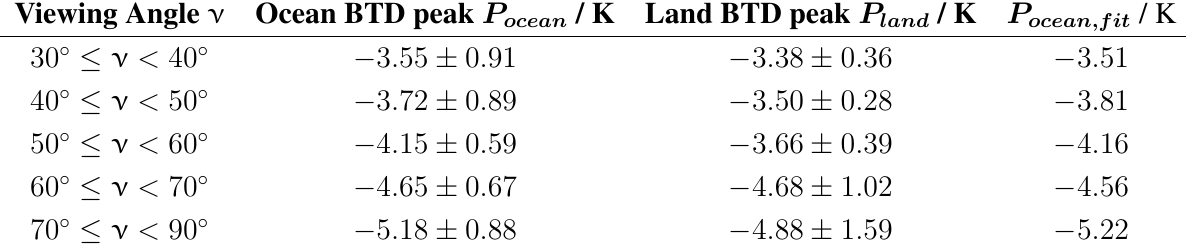
Table 2. Brightness temperature differences for European cloudless land and ocean pixels for different satellite viewing angles. In the right column, Equation (8) has been applied on the interval center angles given in the left